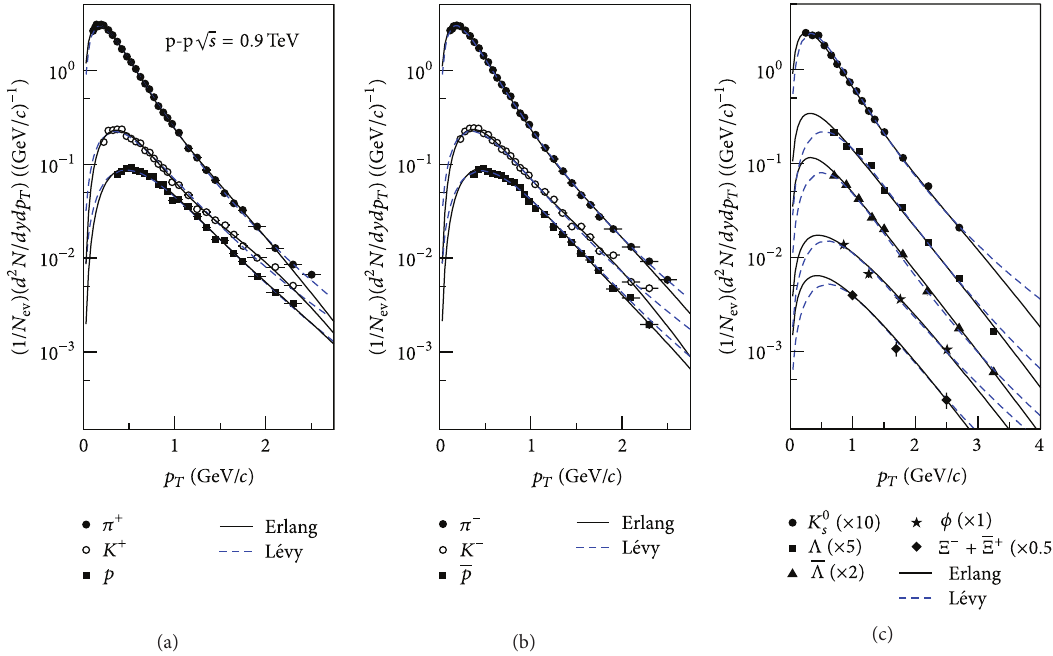
̄Λ ̄Ξ + , 𝜙 , and Ξ − + produced in p-p collisions at 0.9 TeV.